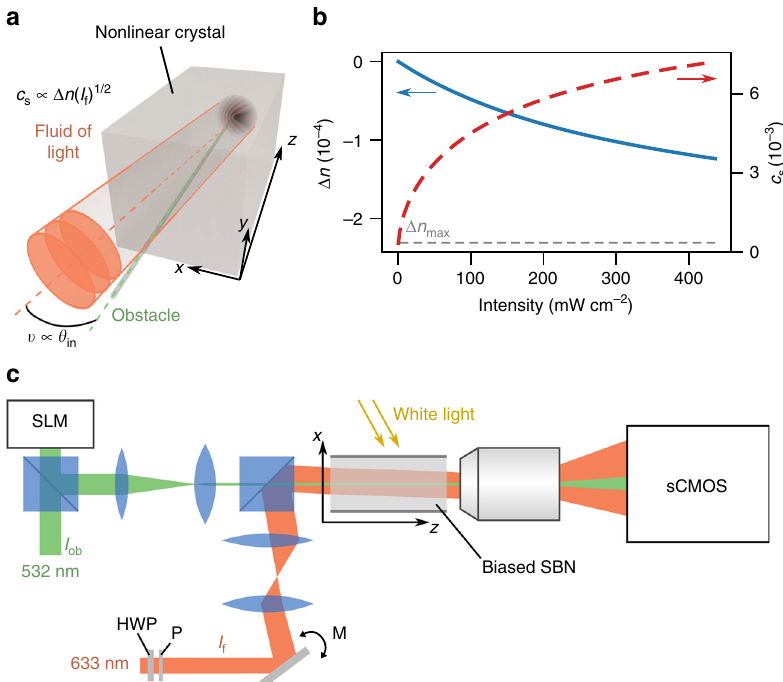
Fig. 1 Realization of a fl uid of light in a propagating geometry and nonlinear response of the bulk crystal. a Sketch of the fl uid of light (red beam) fl owing past an obstacle (green beam). The input velocity v of the fl uid of light is proportional to the input angle θ in . The sound velocity c s depends on the intensity I Δ n with respect to a laser intensity I for the nonlinear photorefractive response of the f of the red beam. b Blue curve. Calculated optical-index variation medium. Red dashed curve. Corresponding sound velocity c s . c Experimental setup. The green beam is shaped by the spatial light modulator (SLM) to create a z -invariant optical defect acting as a localized obstacle in the transverse plane. The red beam is a large gaussian beam and creates the fl uid of light. I θ f is controlled by a half-waveplate (HWP) and a polarizer (P). in is tuned by rotating a mirror (M) imaged at the input of the crystal via a telescope. Both are propagating simultaneously through a biased SBN photorefractive crystal and imaged on a sCMOS camera. The white light controls the saturation intensity of the